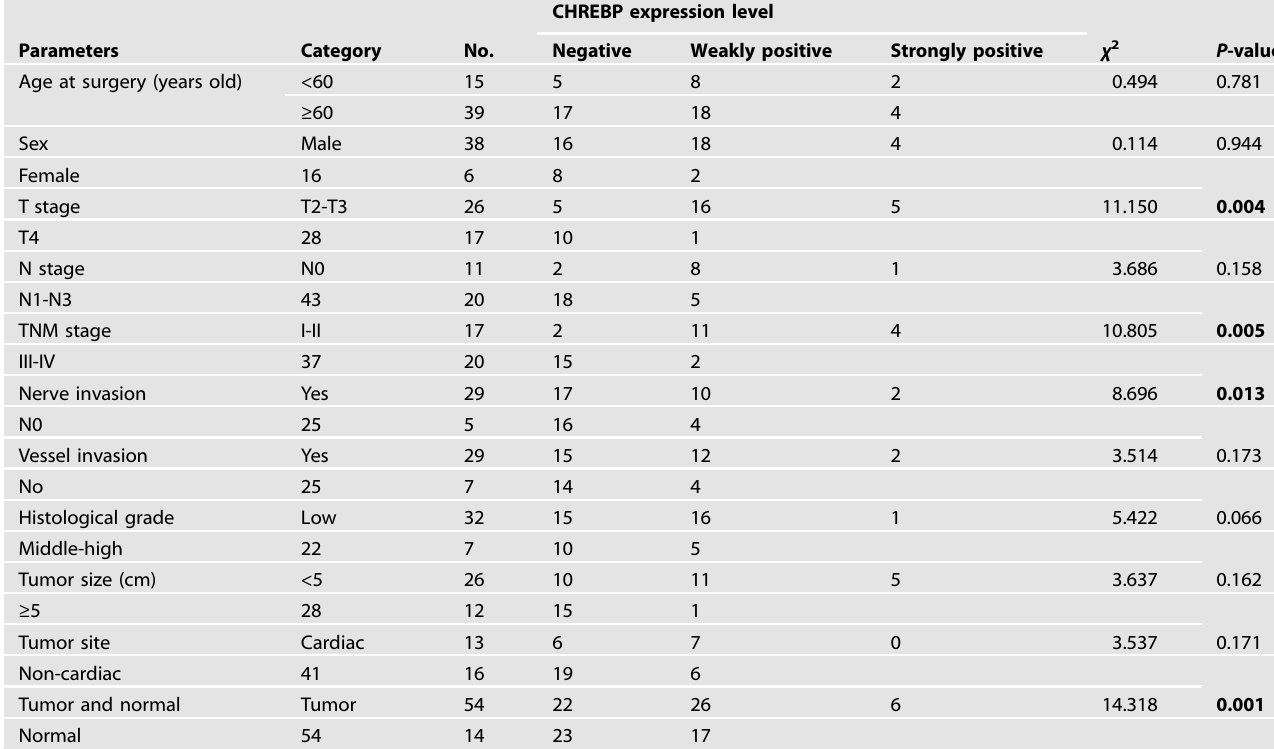
Table 1. Correlation between the level of CHREBP and the pathological parameters of GC samples ( n =